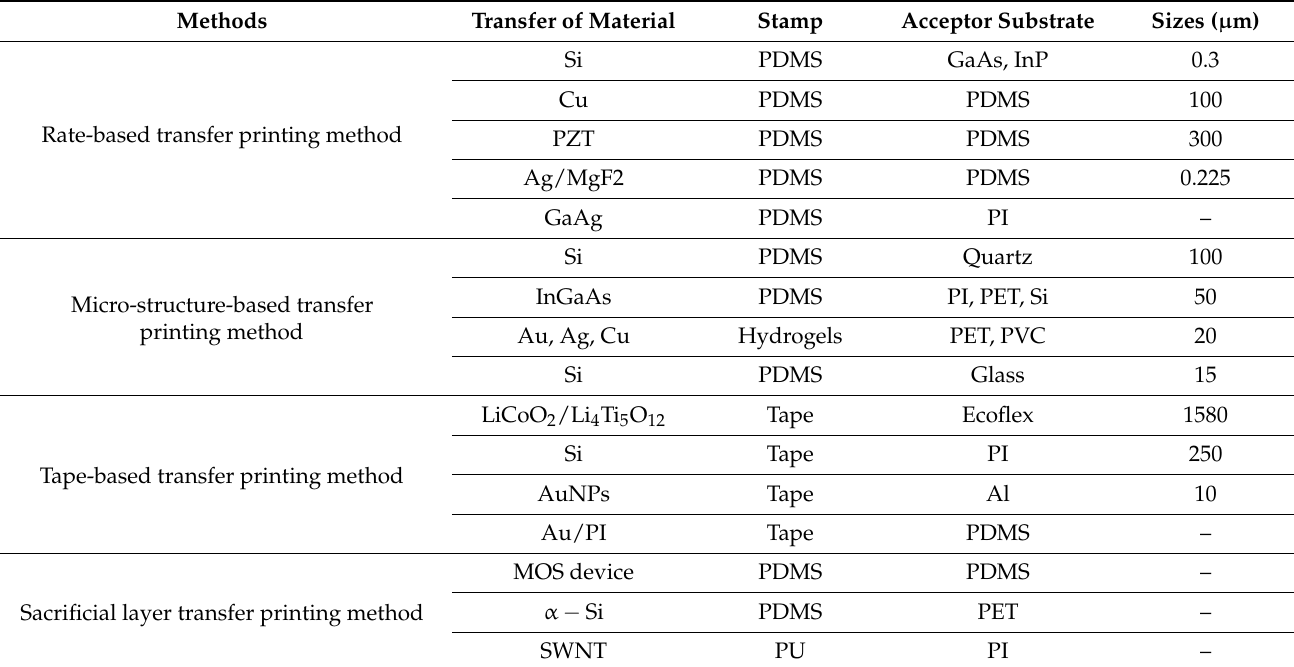
Table 7. Commonly used transfer printing